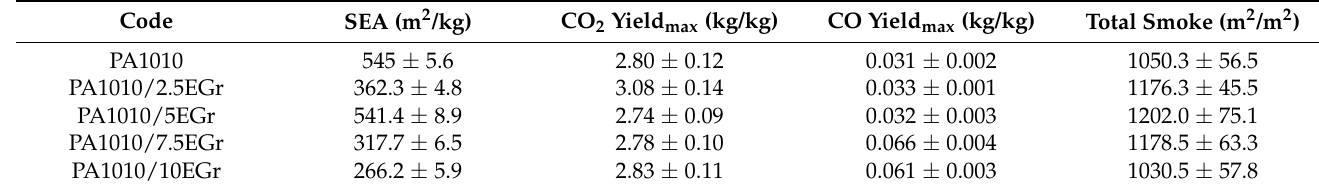
Table 8. Smoke parameters obtained with CCT on the PA1010 and EGr